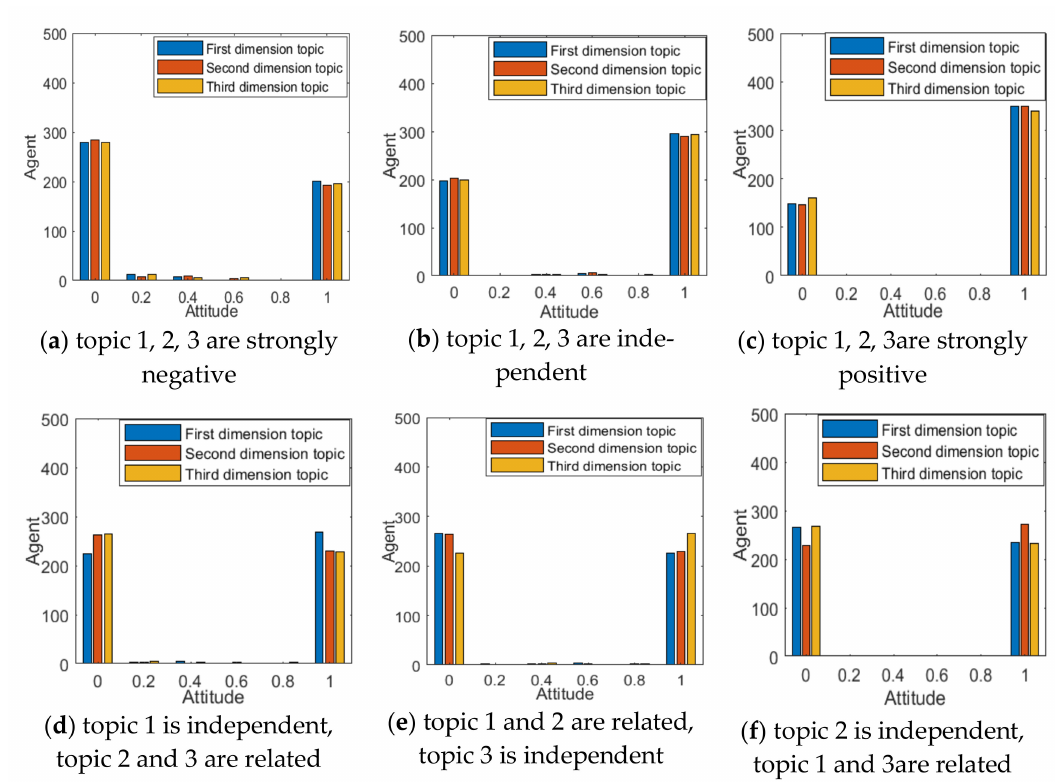
Figure 12. Histogram of group attitude distribution under different topic correlations.